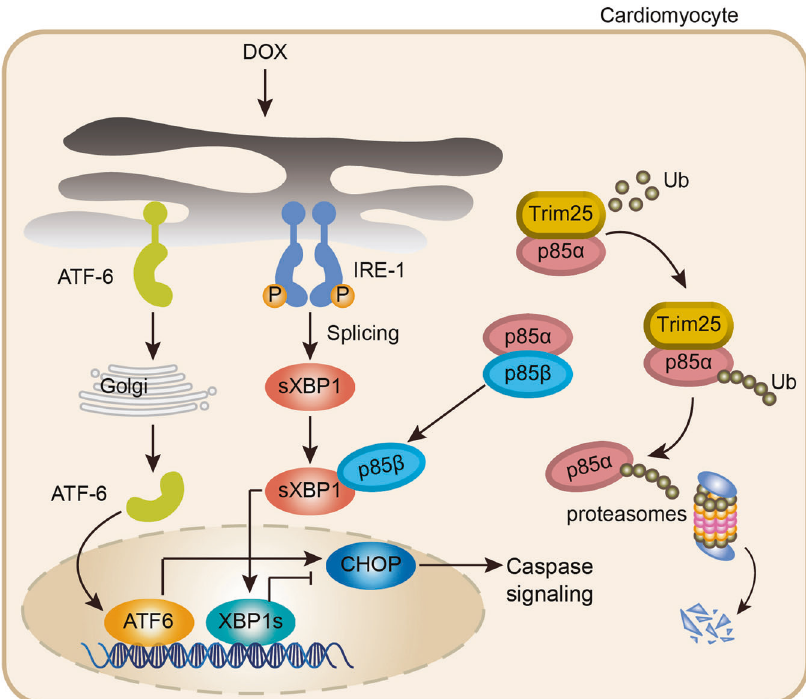
Fig. 8 Schematic diagram of the molecular mechanisms underlying TRIM25-regulated DOX-induced cardiotoxicity. A schematic model illustrating that TRIM25 regulates the p85 α /XBP-1s/CHOP signaling pathway under ER stress to decrease myocardial apoptosis. TRIM25, which is downregulated after treatment with DOX, could alleviate ER stress by targeting p85 α for ubiquitination and degradation, leading to increased XBP-1s transferring to the